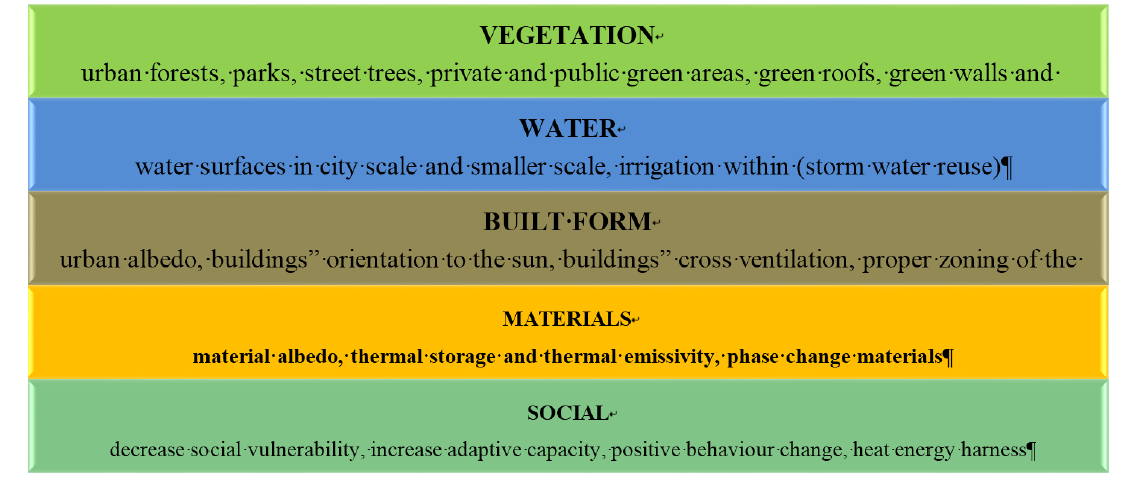
Figure 3. The five categories of UHI mitigation and adaptation strategies